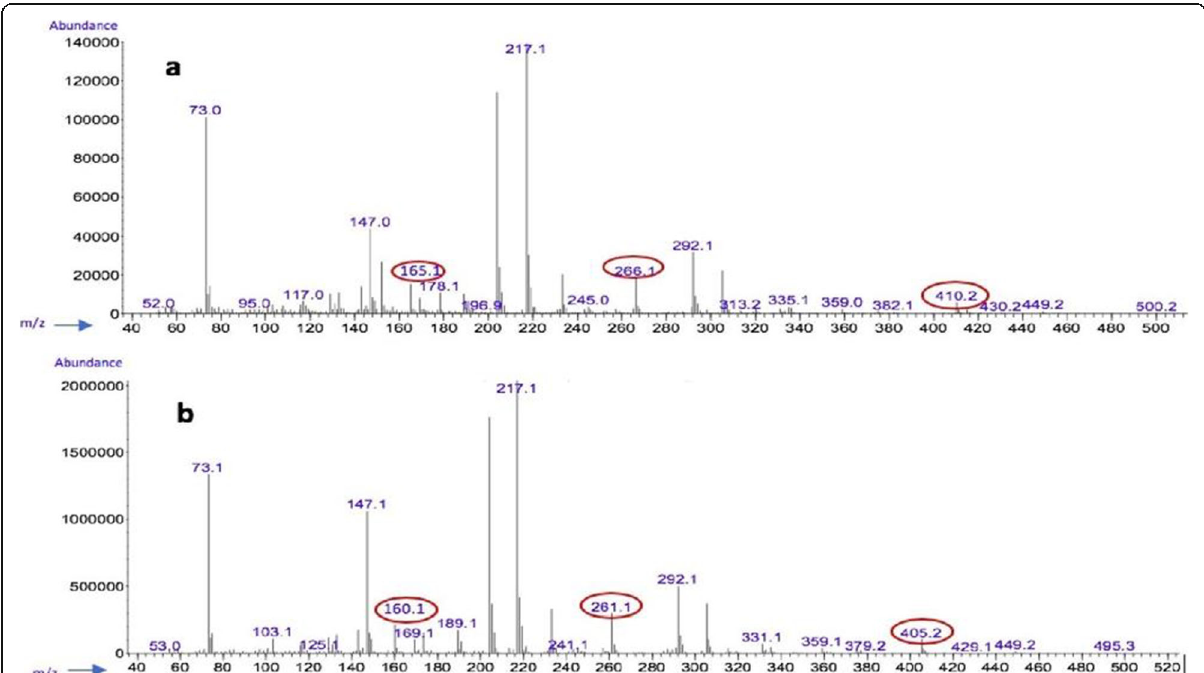
Fig. 2 a Mass fragmentation pattern of tri-methylsilyl derivatives of EtG-D 5 (IS). b Mass fragmentation pattern of tri-methylsilyl derivatives of EtG